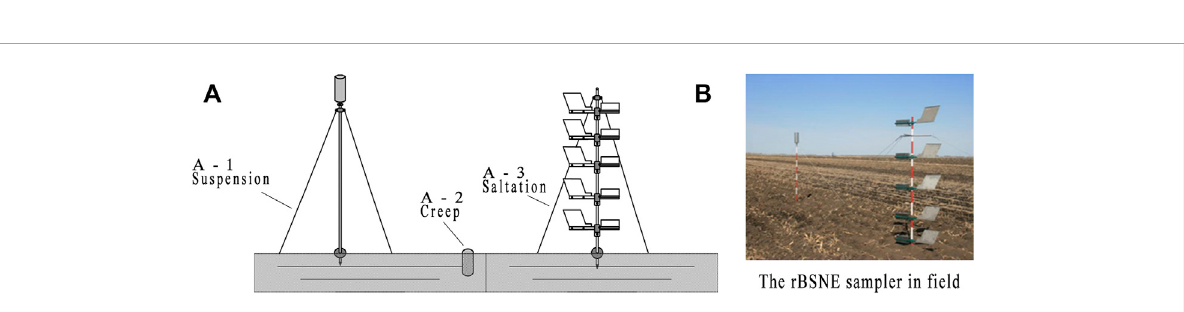
FIGURE 3 Collection system for soil erosion used in this study. ( A-1 , A-2, and A-3 are the collection subsystems of soil particle by suspension, creep, and saltation, respectively; (B) is the rBSNE sampler in the fi